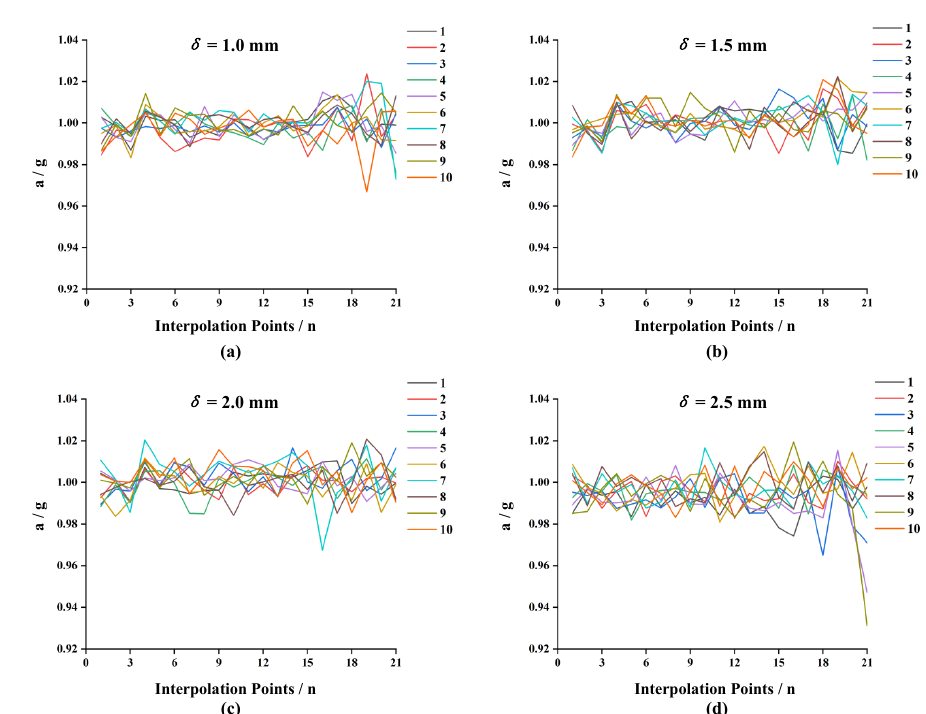
Figure 8. Statistics of the acceleration variation on the X -axis, consisting of four sets of bark consump- tion settings.